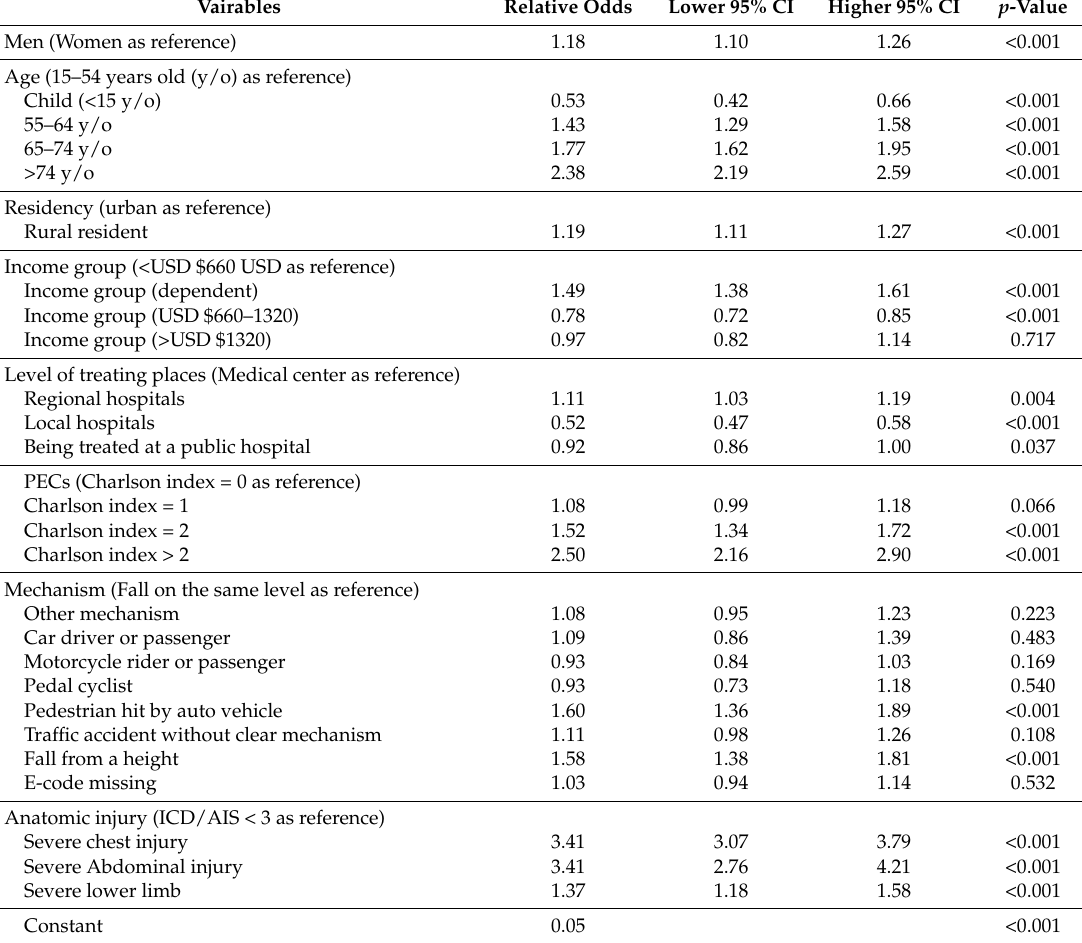
Table 5. Regression results. Adjusted odds of in-hospital death for the patients with moderate-to-severe head